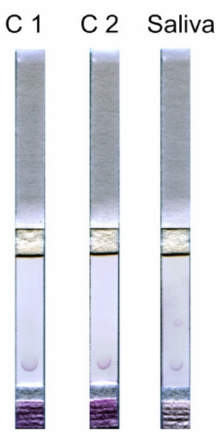
Figure 4. Control experiment with saliva components. C1—test performed with the HSA solution (3 mg/mL), and C2—test performed with the human immunoglobulin solution (1 mg/mL). For comparison, on the right there is a test carried out with saliva as the analyzed liquid. The test was carried out simultaneously with the control